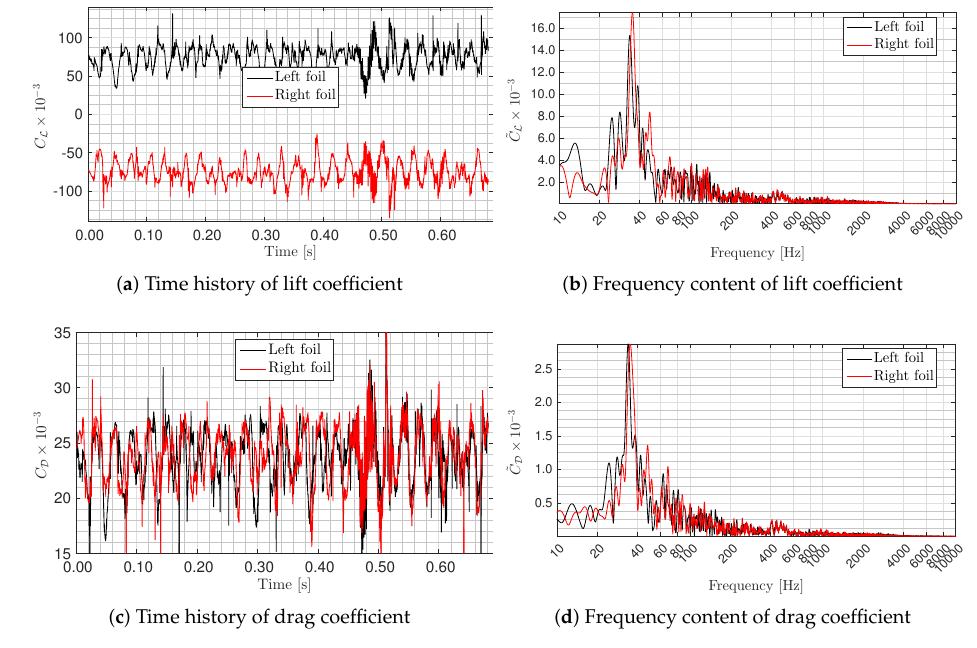
Figure 10. Time history and frequency content of the lift and drag coefficients. Medium grid, σ = 0.53, DDES.